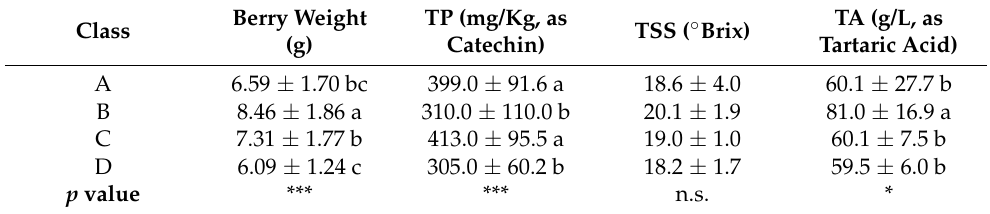
Table 1. Basic maturity